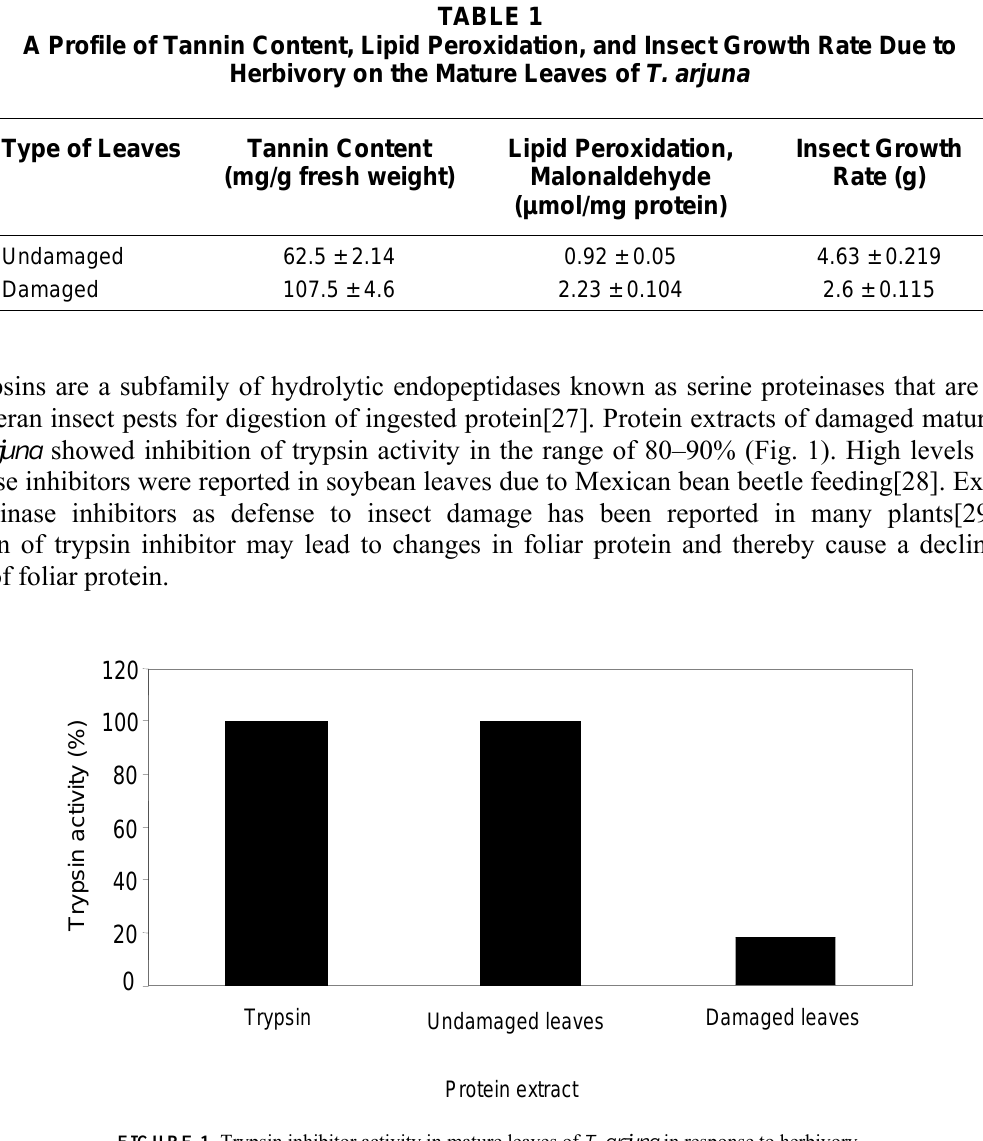
FIGURE 1 . Trypsin inhibitor activity in mature leaves of T. arjuna in response to